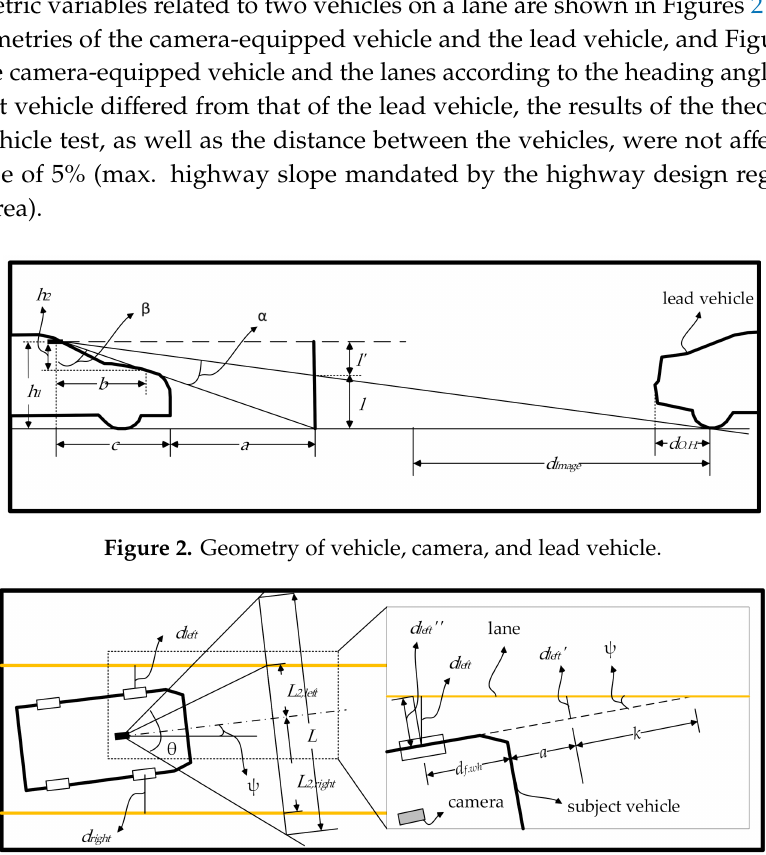
Figure 3. Geometry of a vehicle on lane according to heading